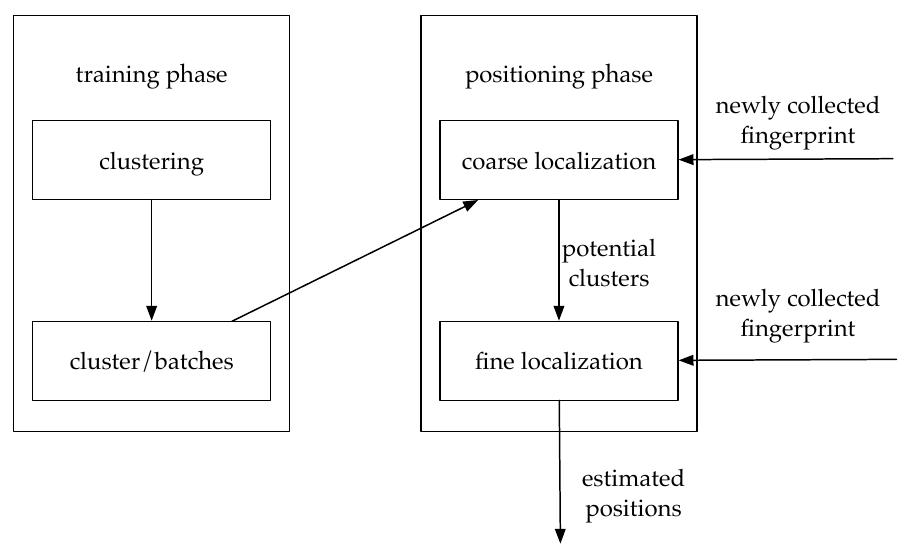
Figure 1. The clustering-positioning implementation for fingerprinting-based WLAN positioning.